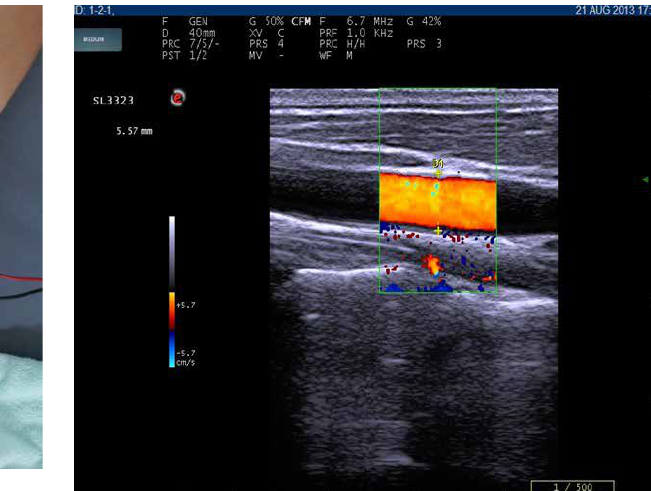
Figure 4: Measurement of carotid artery vessel